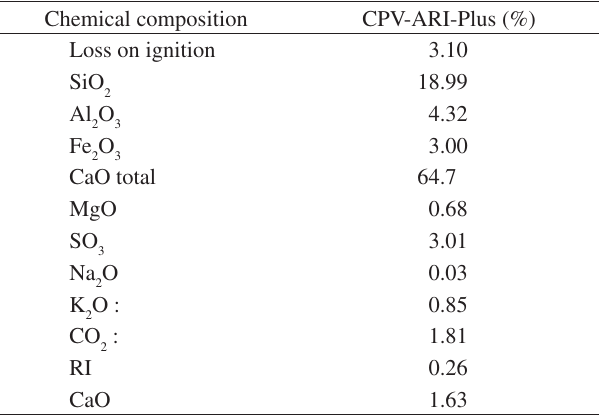
Table 1. The chemical composition of cement.